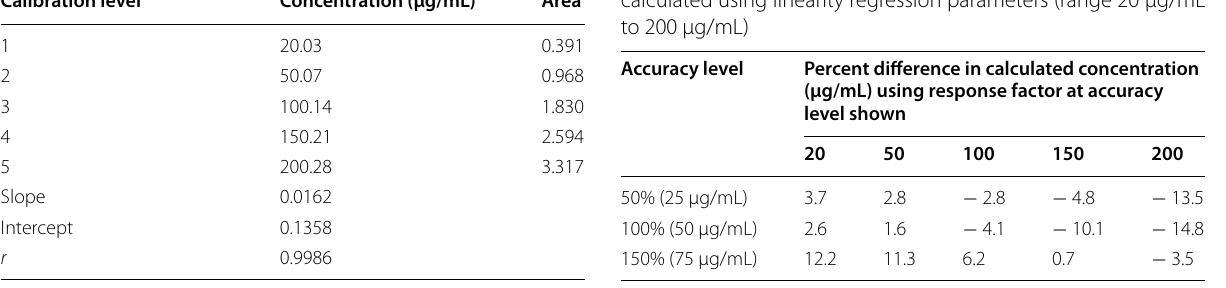
Table 1 Succinate linearity (range 20 μg/mL to 200 μg/mL) Calibration level